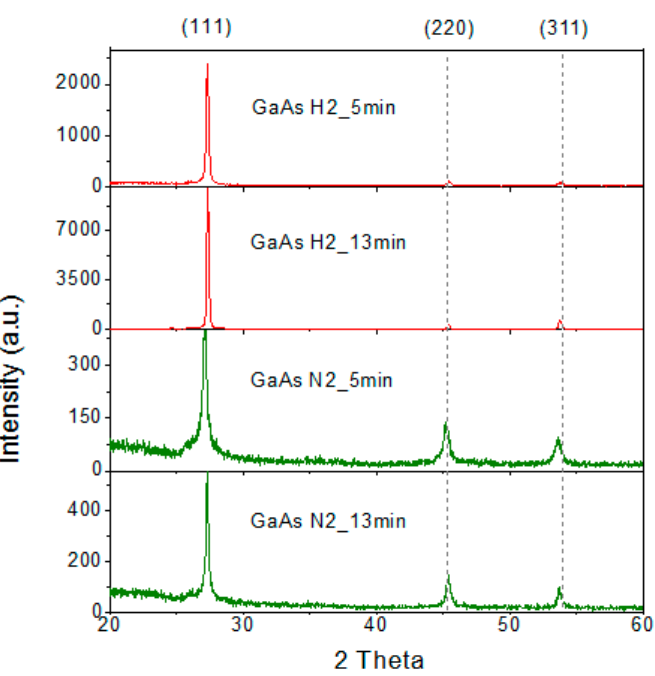
Figure 4. X-ray diffraction patterns of the GaAs films by CSVT using H 2 and N 2 as reactant gas. Table 3. It summarizes the FWHM sample of peak (111) from XRD and the peaks from Raman spectra. These values were determined by fitting a Gaussian function. The crystallite size was obtained by Scherrer’s